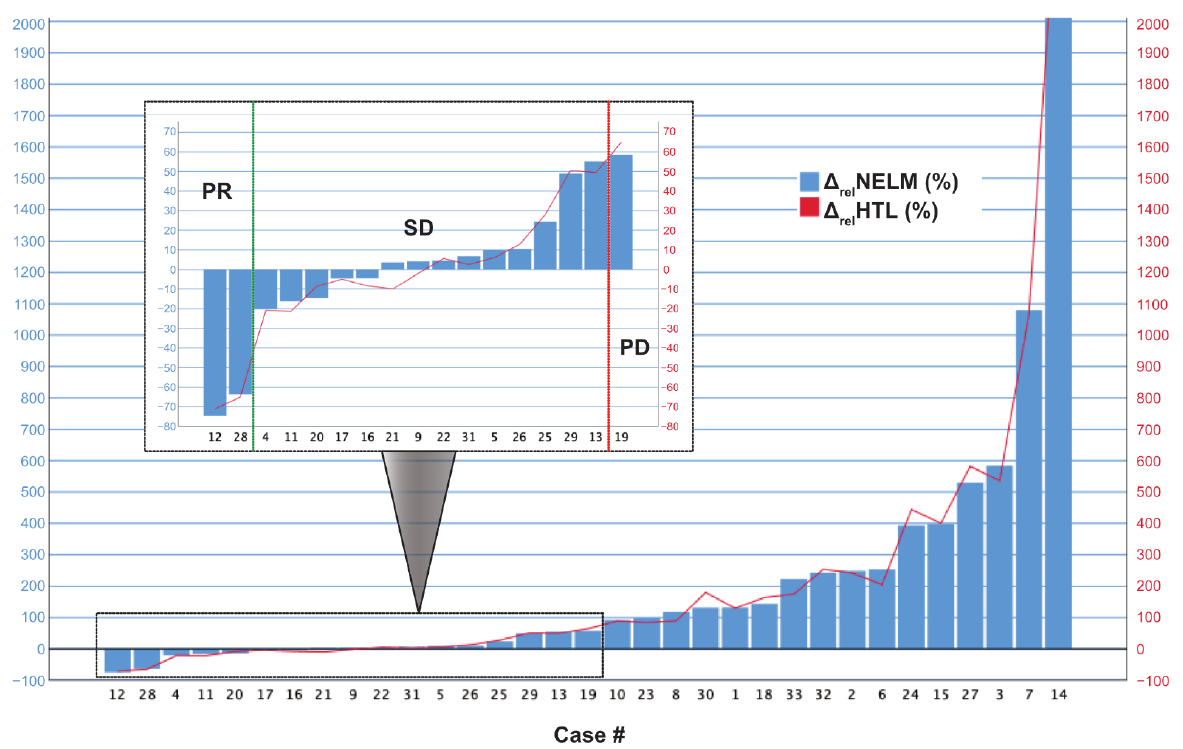
Figure 4. Case-wise illustration of the relative volume changes (Δ rel NELM and Δ rel HTL) between baseline and follow-up examination in the MCC cohort. The box within the figure shows an optimized scaling of cases with less change to illustrate the significance thresholds for partial response (PR) and progressive disease (PD).